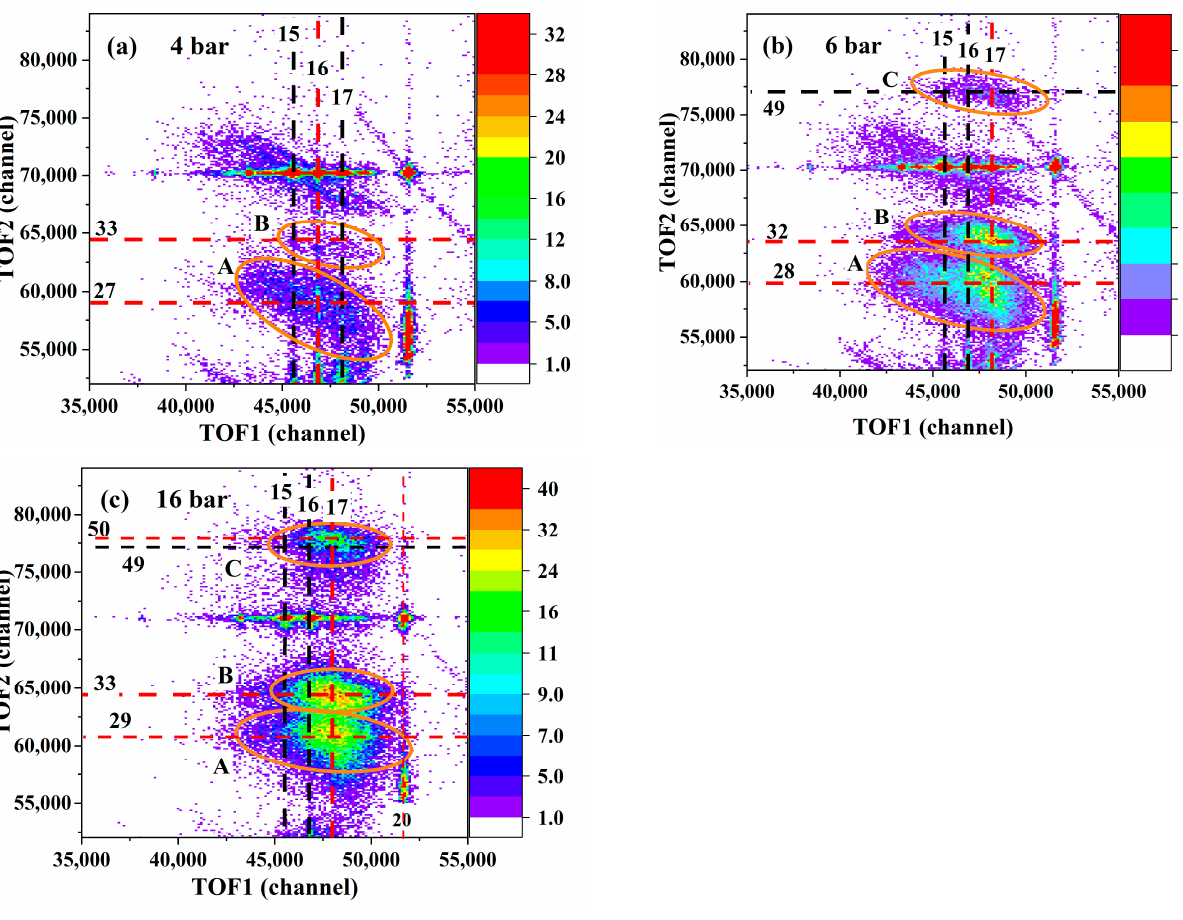
Figure 2. The 2D TOF spectrum of the ions after electron impact ionization at the stagnation pressure of ( a ) 4 bar, ( b ) 6 bar, and ( c ) 16 bar. Region A represents the CH 4+ /C 2 H m+ or CH 5+ /C 2 H m+ coincident island, while region B represents the CH 4+ / CH 4 CH 5+ or CH 5+ / CH 4 CH 5+ coincident island.